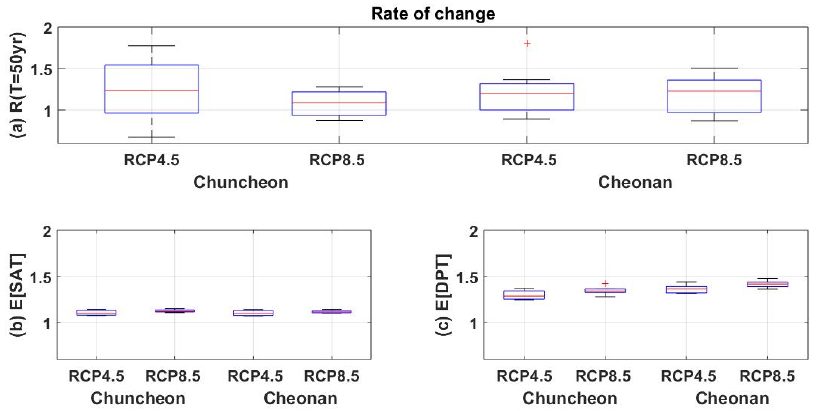
Figure 4. Rate of change of ( a ) daily rainfall quantile for return level of 50 years, ( b ) annual mean SAT, and ( c ) annual mean DPT. The rate of change is calculated as the ratio of the x value of the future period (2021–2050) to the x value of the present period (1981–2010) for each of the eight climate model combinations. Here, x is ( a ) the daily rainfall quantile for a return level of 50 years, ( b ) the annual mean SAT, and ( c ) the annual mean DPT, respectively.